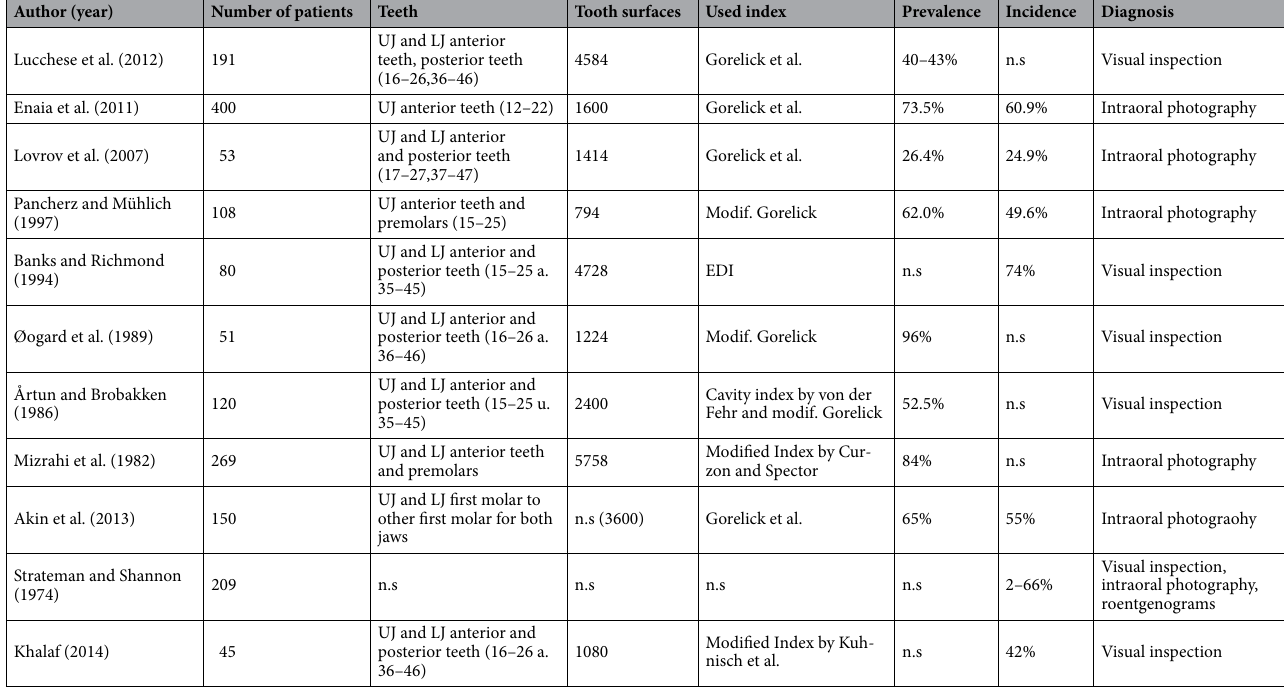
Table 1. Literature overview of the corresponding parameters for analyzing the prevalence and the incidence of WSL after MB